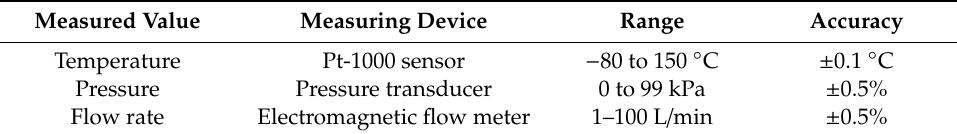
Table 2. Measuring devices and their main parameters.